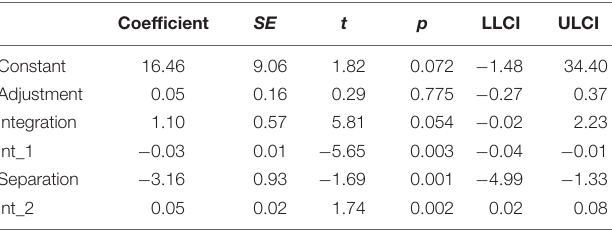
TABLE 9 | Moderation model with turnover intentions as dependent variable (WtWE).